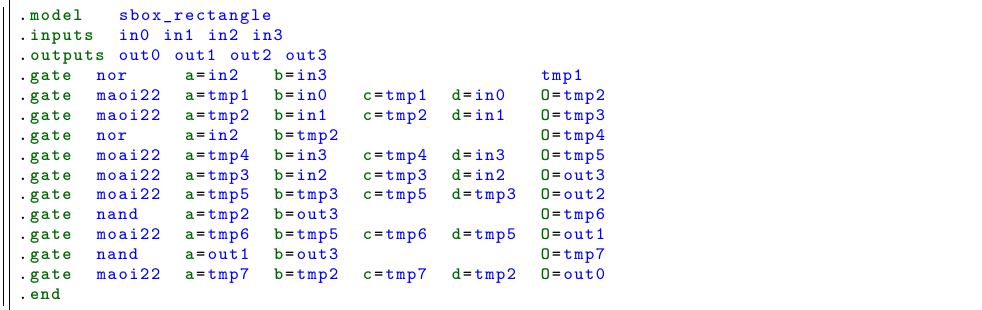
Figure 14: Area-optimized hardware implementation of Rectangle Sbox using 21.50 GE with the standard cell library of the TSMC 65nm logic process.